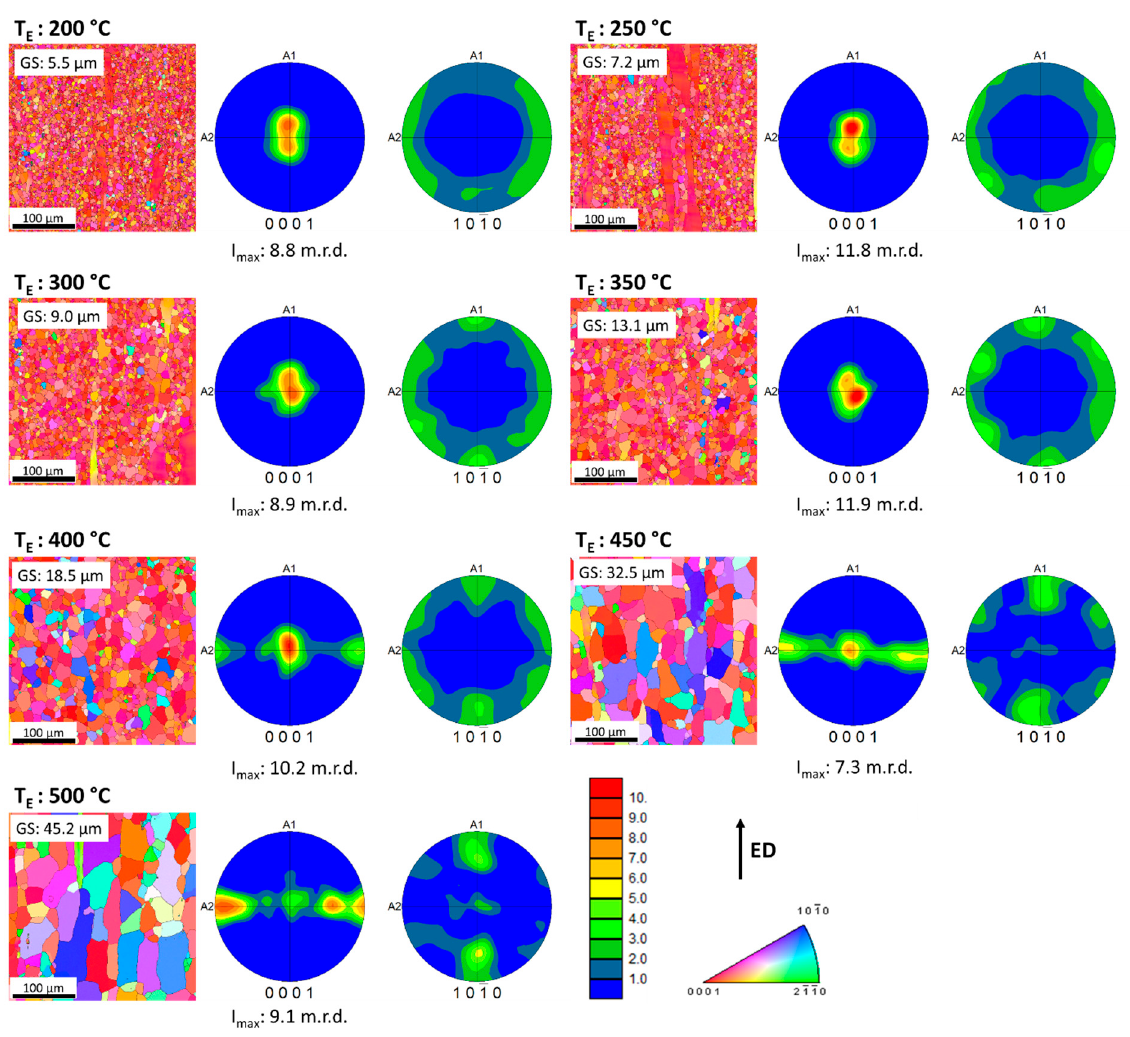
Figure 2. Inverse pole figure maps of the extruded AZ31 bands.